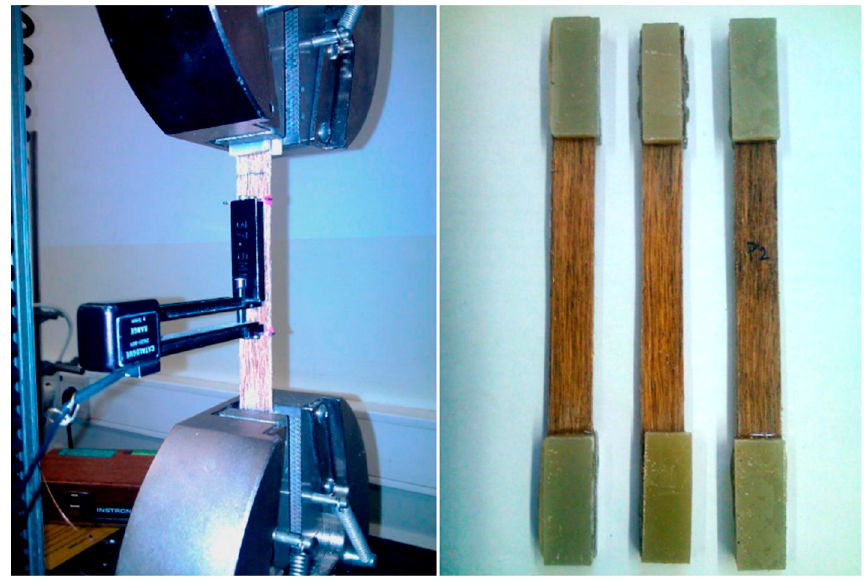
Figure 3. Tensile test ( left ) and test samples ( right ).